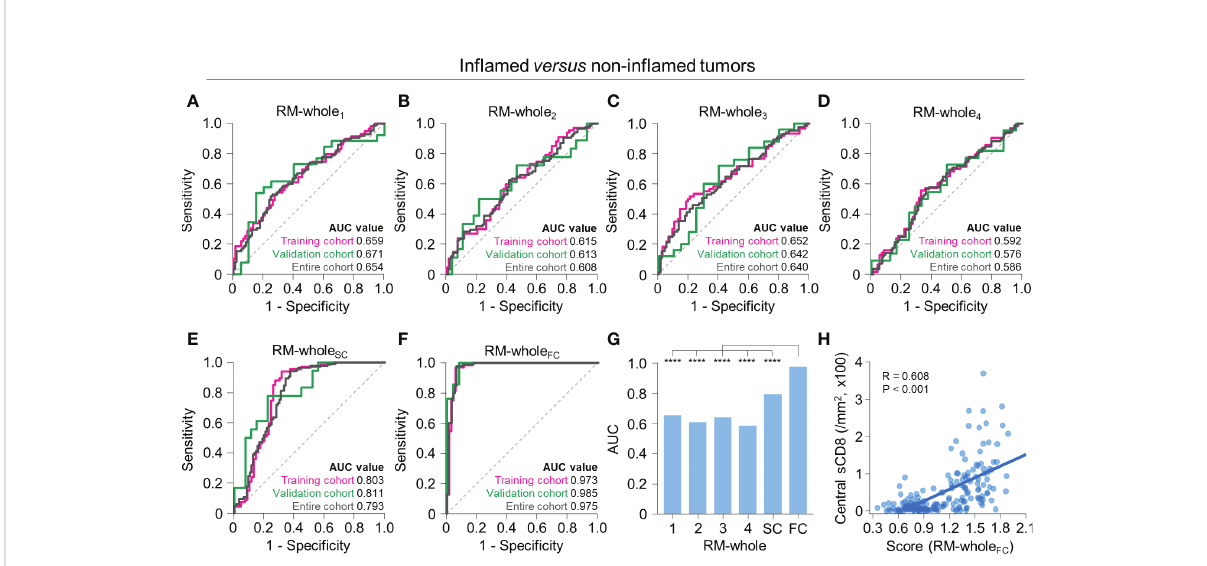
FIGURE 3 Radiomic models to predict immune-in fl amed versus non-in fl amed immunophenotypes on the basis of radiomic features from the whole tumor. (A – F) The receiver operating characteristic curves of RM-whole 1 (A) , RM-whole 2 (B) , RM-whole 3 (C) , RM-whole 4 (D) , RM-whole SC (E) , and RM-whole FC (F) for discriminating between immune-in fl amed and non-in fl amed tumors in the training ( pink ), validation ( green ), and entire cohorts ( gray ). (G) The comparison of the AUC values of the six radiomic models derived from the whole tumor. (H) The correlation between the radiomic score obtained from RM-whole SC and the central stromal CD8 + T cell density. Statistical analyses were performed using Delong ’ s test (G) and Pearson ’ s correlation test (H) . **** P < 0.0001. RM, radiomic model; AUC, area under the receiver operating characteristic curve; sCD8, stromal CD8 + T